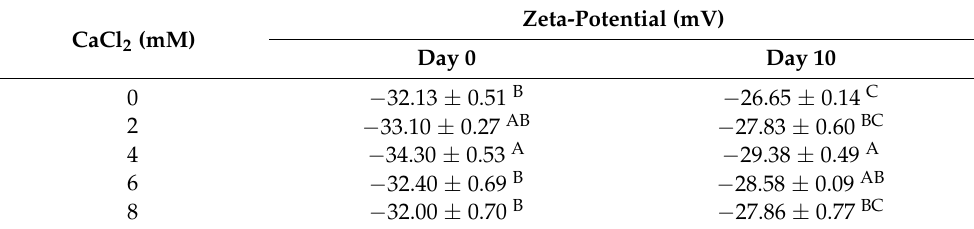
Table 2. Zeta-potential of the filled hydrogels containing different CaCl 2 levels for fixed storage times (0 and 10 days).